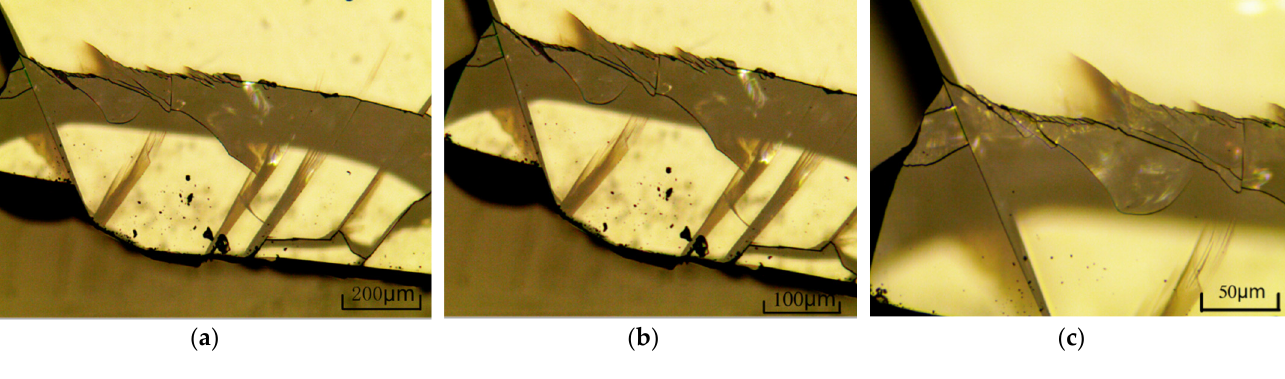
Figure 2. The fragmentation of sapphire material under mechanical action. ( a ) 50×. ( b ) 100×. ( c ) 200×.